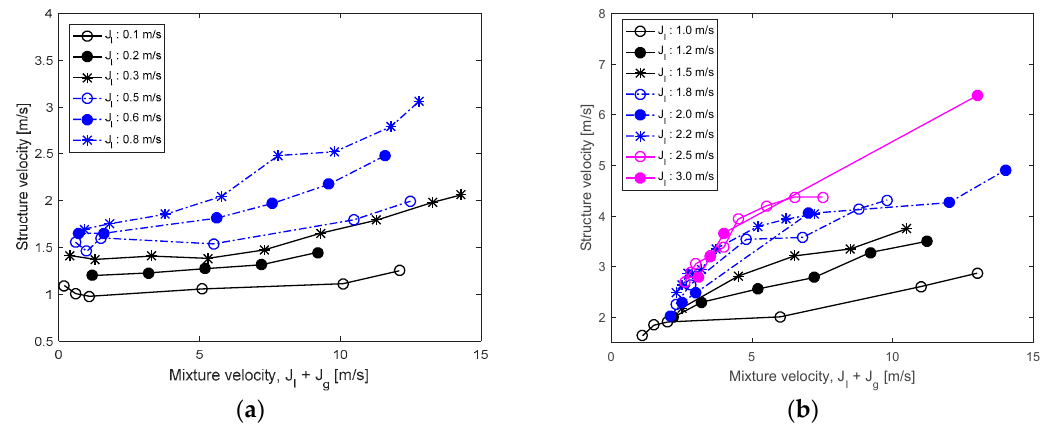
Figure 14. The relationship between the structure velocity and the mixture velocity: ( a ) j l = 0.1~0.8 m/s; ( b ) j l = 1.0~3.0 m/s.